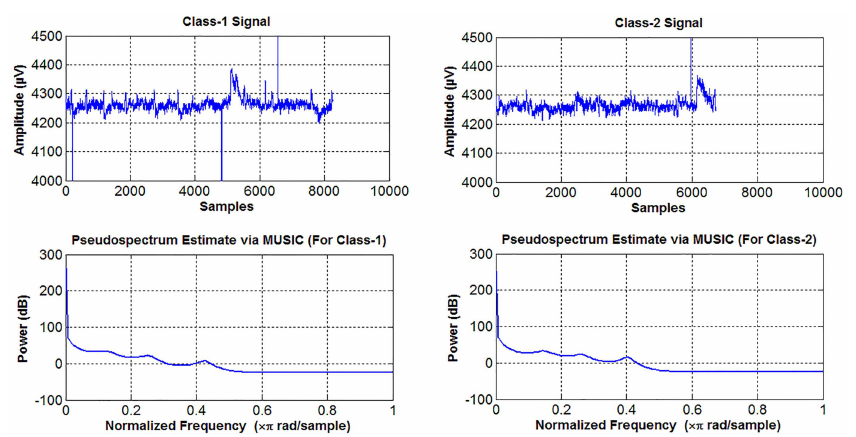
Fig 1. Display of a sample EEG signal represented in the time-amplitude and frequency-amplitude